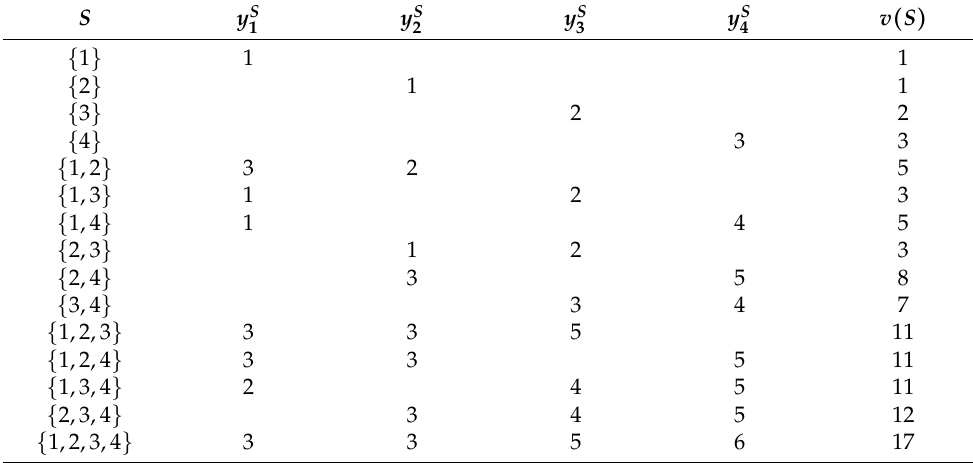
Table 1. PMAS profit game ( N , v , (cid:23) ) for Example 1.